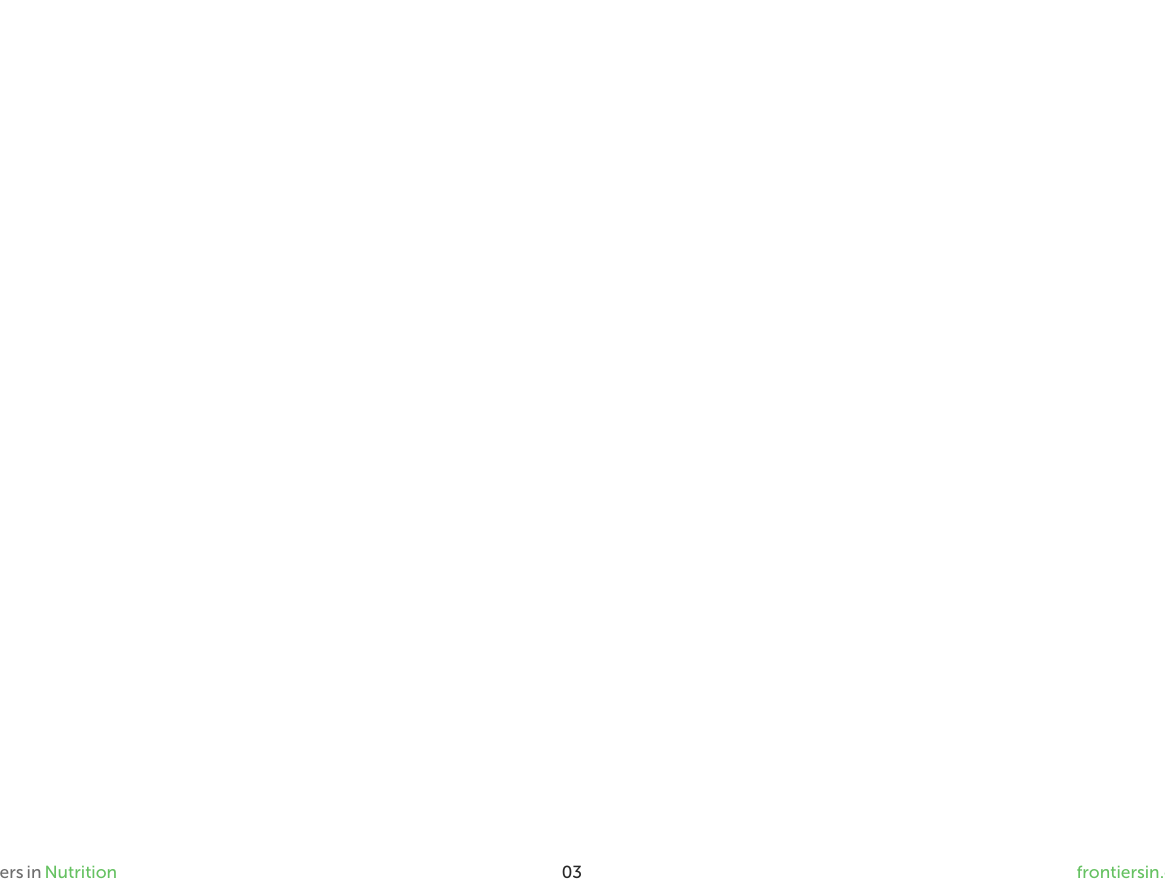
FrontiersinNutrition